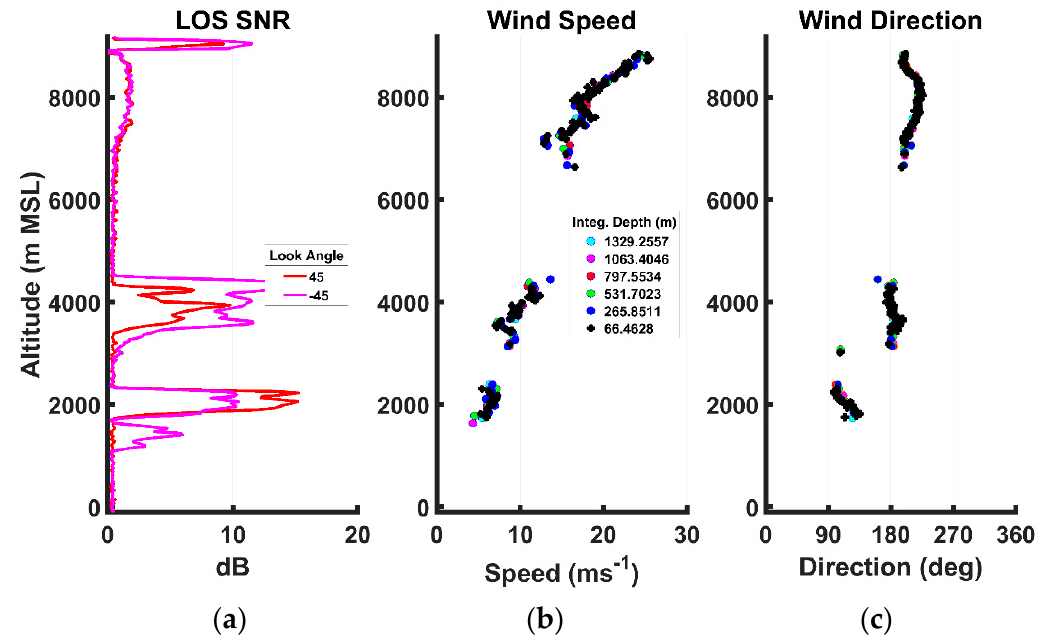
Figure 19. DAWN vertical profiles of SNR ( a ), wind speed ( b ) and wind direction ( c ) NW of the center of TS Cindy at 203415Z on 21 June 2017.